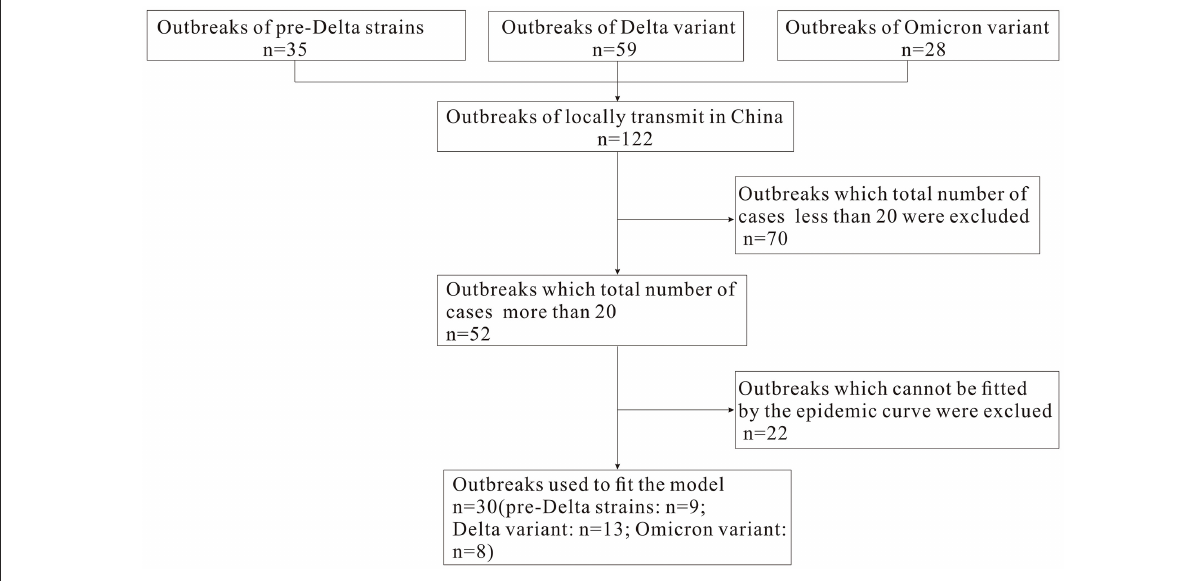
FIGURE1 Flow chart of select outbreaks for fitting R eff and R t value.